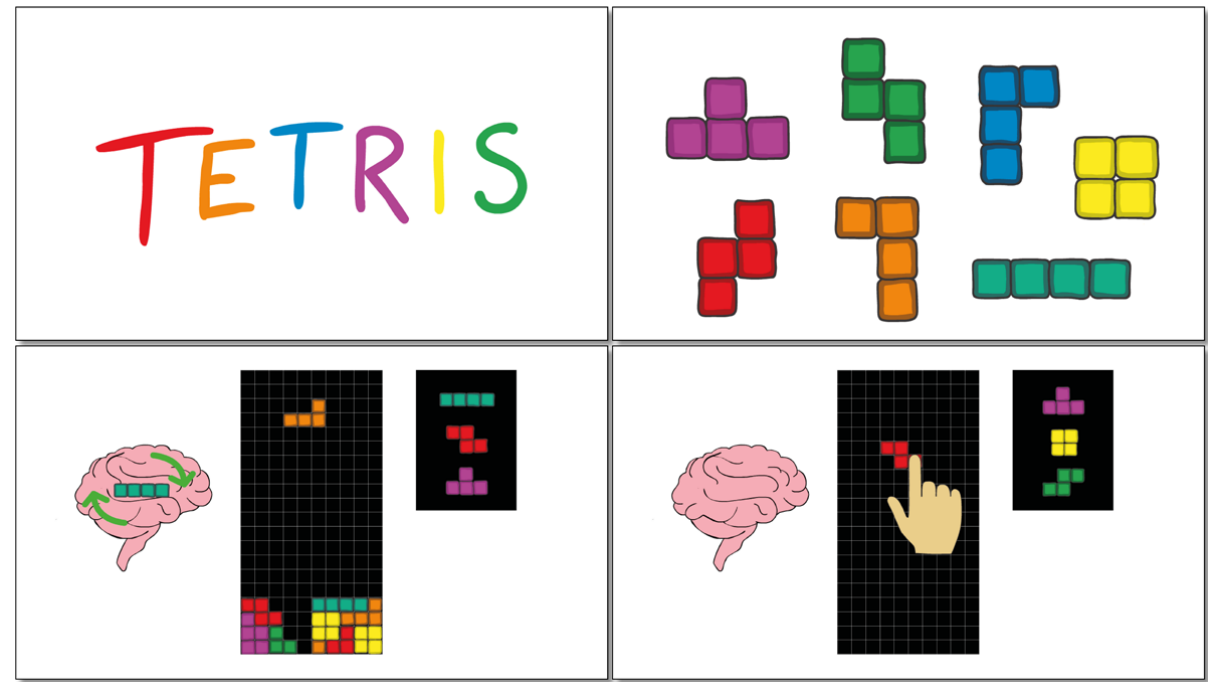
Figure 2. Screenshots from the “How to Play Tetris” video, which instructs participants on how to complete the imagery-competing task in the specific way required (eg, by emphasizing "mental